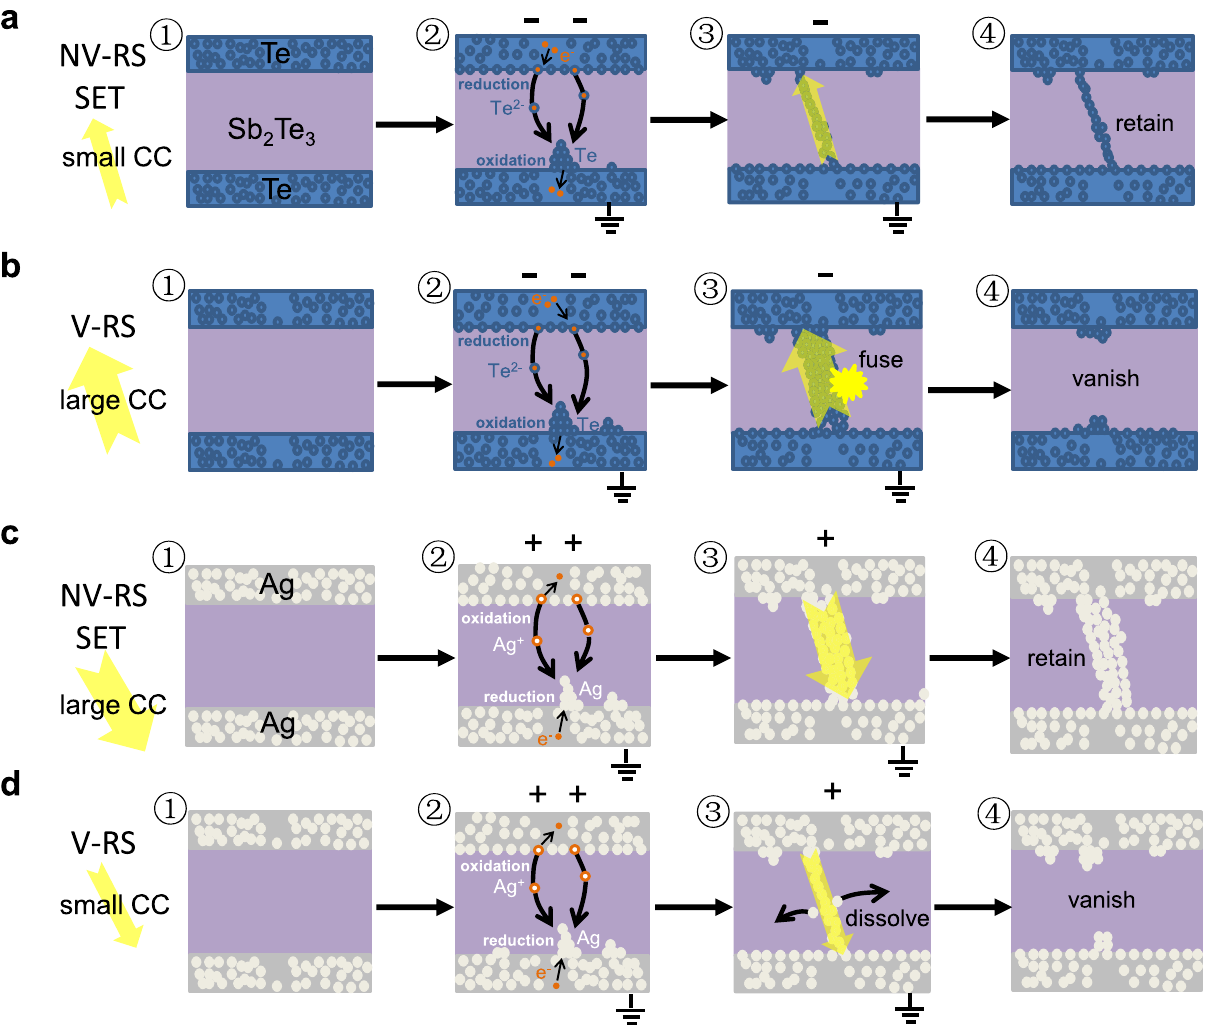
Fig. 3 Schematic comparison of the fi lamentary RS processes between the Te fi lament-based device and the metallic fi lament-based device. ( a ) NV-RS process under low CC in TST device. ( b ) V-RS process under large CC in TST device. ( c ) NV-RS process under large CC in Ag fi lament-based device. ( d ) V-RS process under low CC in Ag fi lament-based